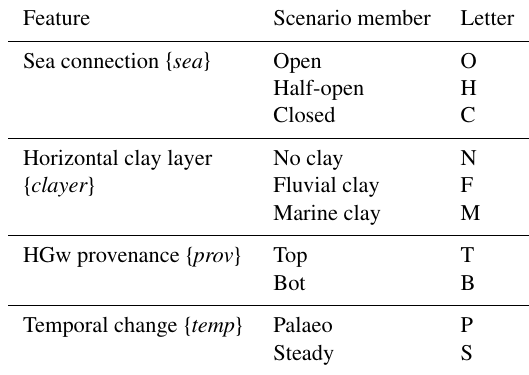
Table 1. Letters that are used to create model scenario